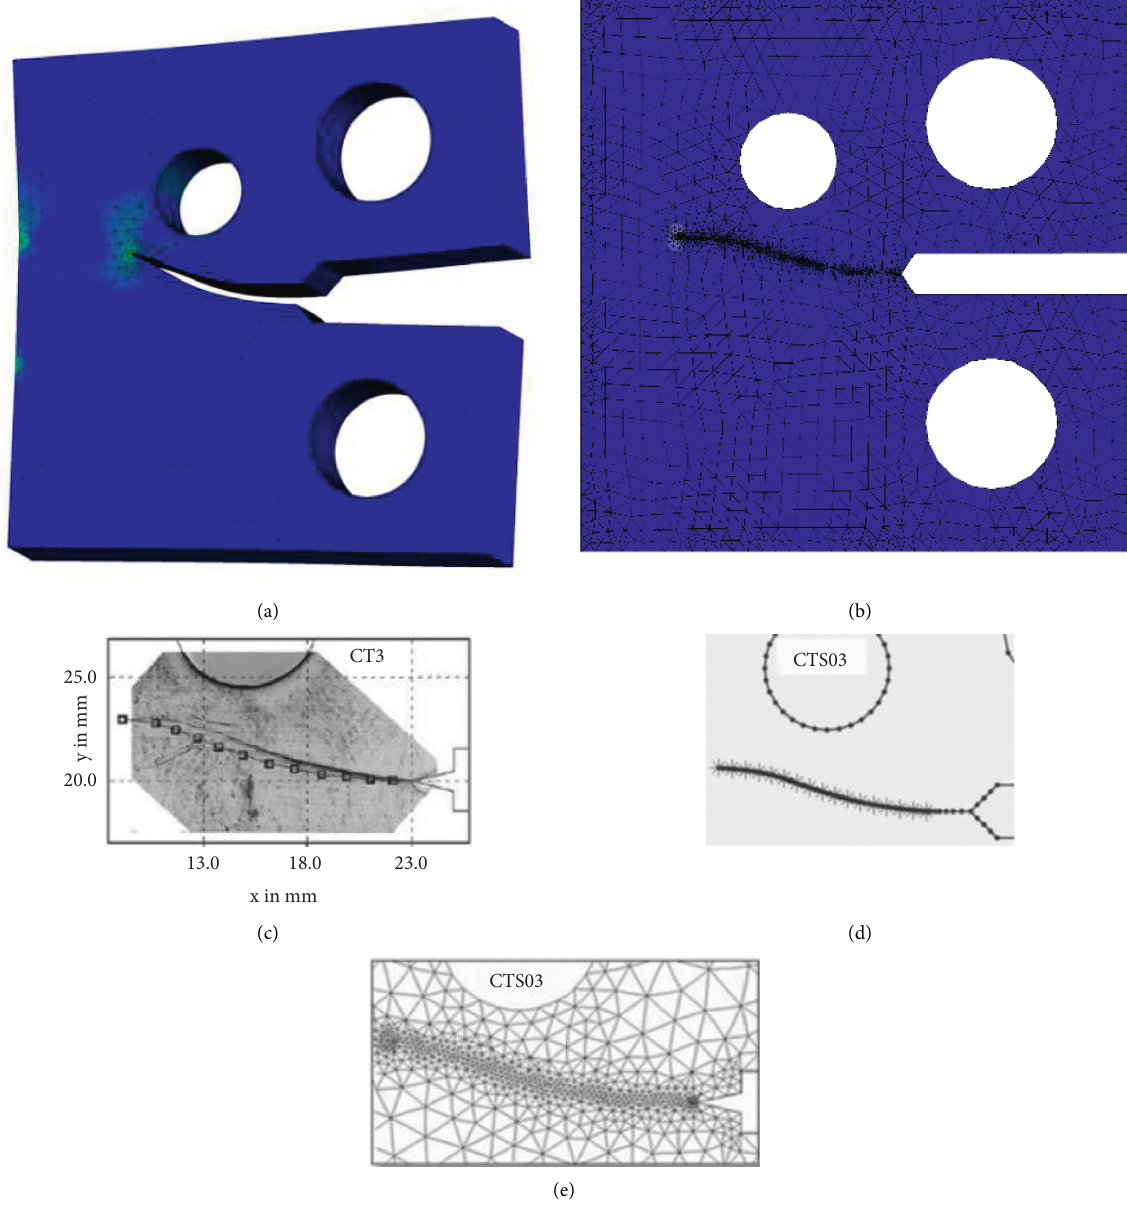
Figure 7: The predicted crack path of CTS03. (a) ANSYS results, (b) FRANC2D/L, (c) experimental and numerical outcome of [50], (d) BemCracker2D software [32], and (e) Quebra2D software